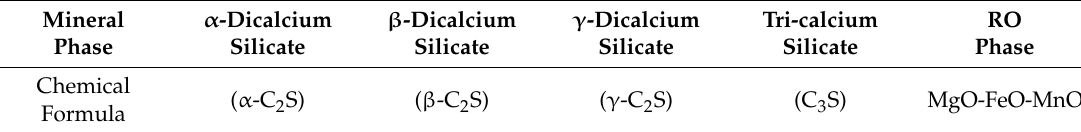
Table 3. Mineral phases in BOF slag [8].